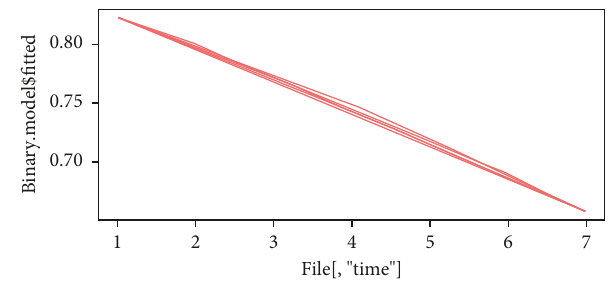
Figure 8: Plot of the probability model.